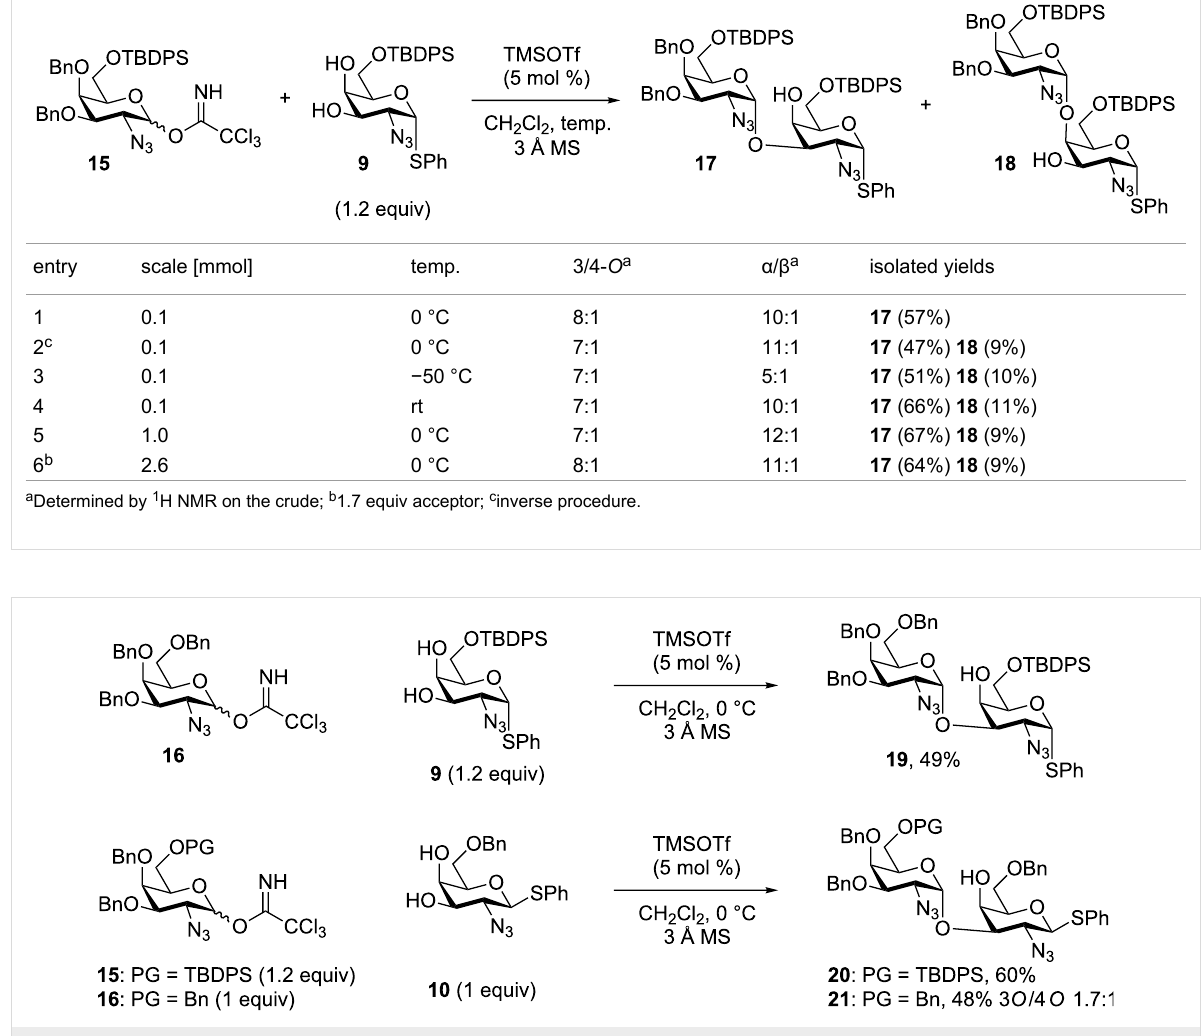
Scheme 3: Challenging the α ,3- O -selectivity with the different 6- O -protecting group variants.